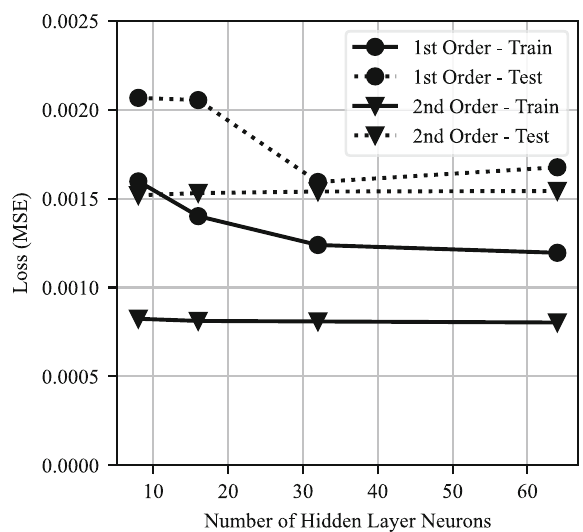
Fig. 4 Losses of models using 1st and 2nd order